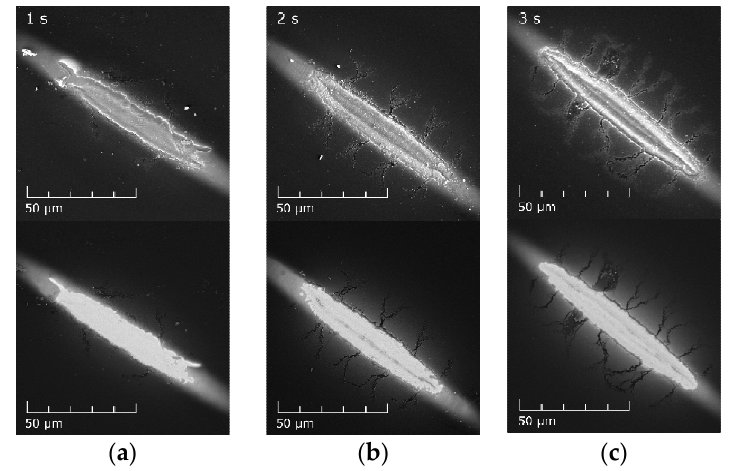
Figure 10. SEM micrographs of free metal wires treated for ( a ) 1 s ( b ), 2 s ( c ) and 3 s at distance H = 0.3 mm. Top row—SE image; bottom row—BSE image.